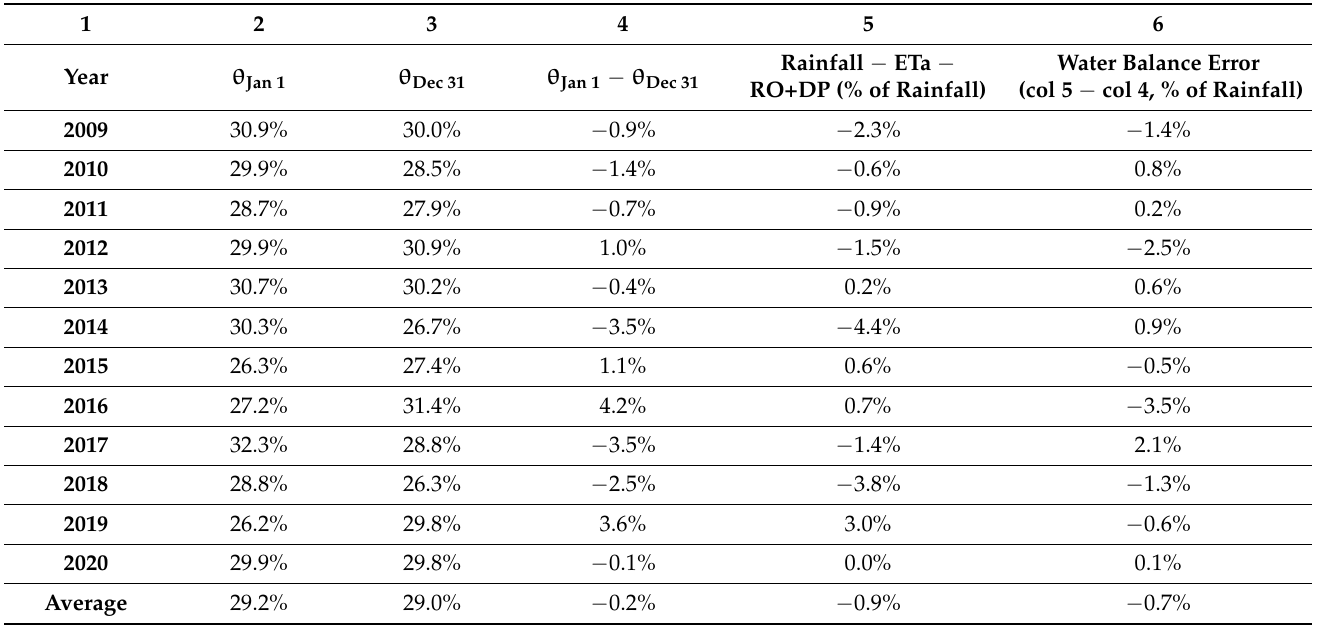
Table 7. GOES-PRWEB water balance (Rainfall − ET a − RO + DP-change in soil